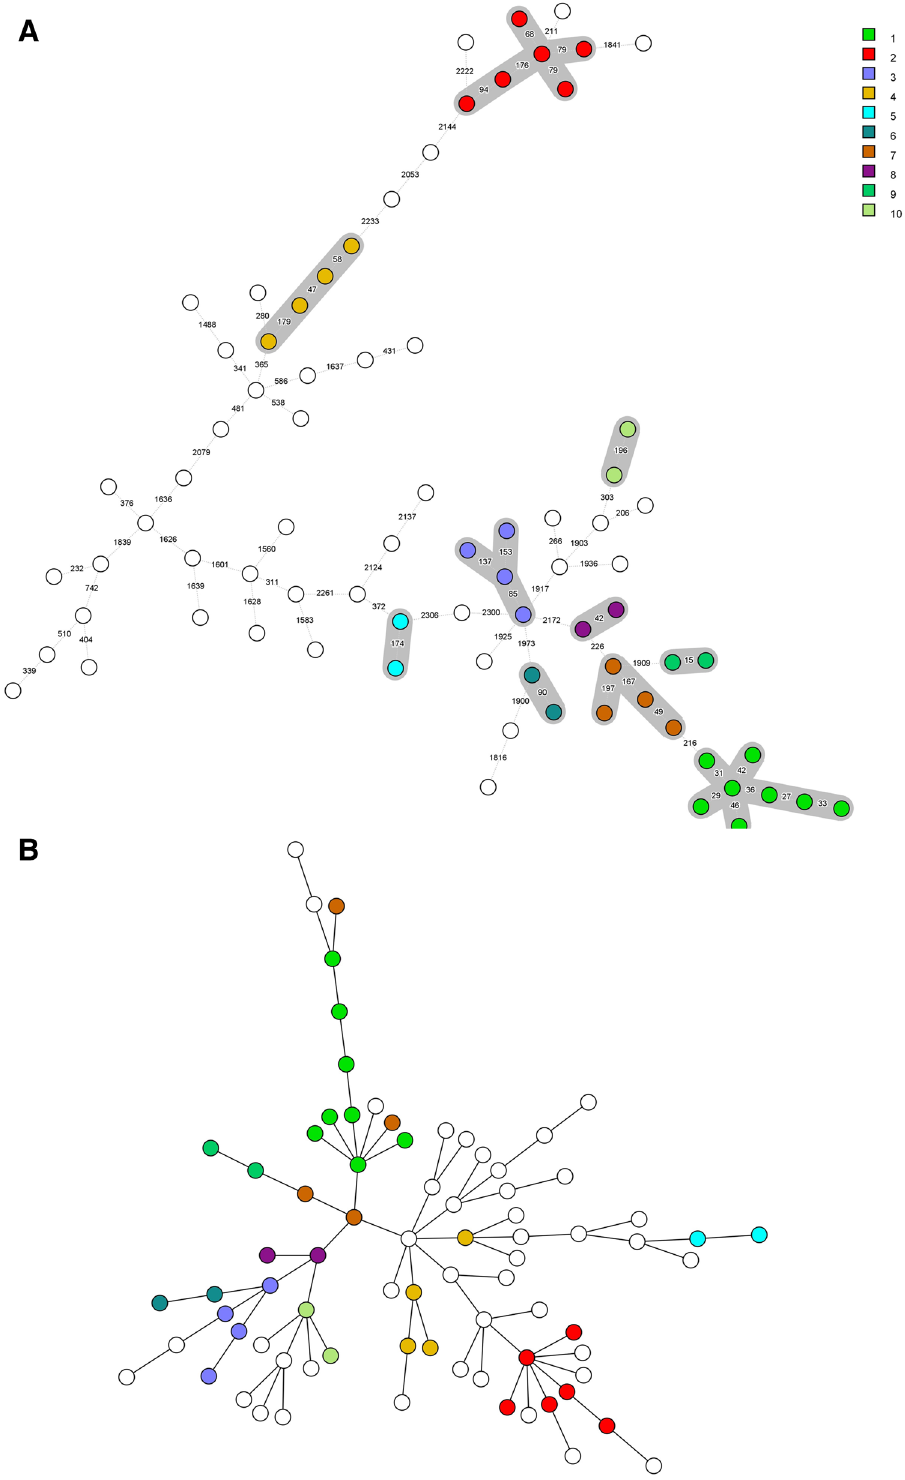
Figure 2. A comparison of sample clustering based on core genome multilocus sequence typing (cgMLST) and clustering based on protein intensity. Each circle represents one isolate. ( A , B ) Display the clustering obtained by cgMLST and protein intensity analysis for the 78 E. coli isolates. ( C , D ) Display the clustering obtained by cgMLST and protein intensity analysis for the 109 K . pneumoniae isolates. Each cluster was indicated with a color and numbered. The same isolates were colored in both the cgMLST and protein intensity